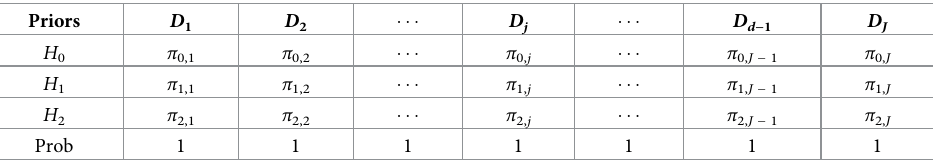
Table 1. Prior probabilities of each dose for three point hypotheses.